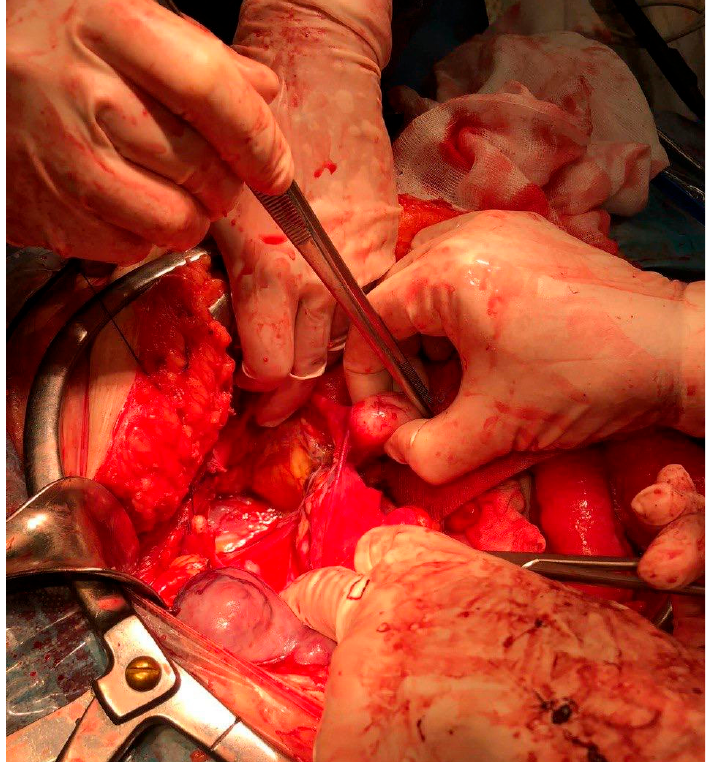
Figure 2. A picture from the operating room after removal of the largest mass. From this shot you can see the numerous rounded formations and how they relate to the other abdominal structures. It was tenaciously adherent to the prevesical peritoneum, to the small intestine, to the left colon and to the sigma. The uterus appeared irregular in shape. The adnexa were both regular in size and shape. Further nodular lesions on the abdominal and pelvic peritoneum were detected. Two omental lesions were also seen. The patient underwent a total hysterectomy, a bilateral salpingo-oophorectomy, and an omentectomy, and all the peritoneal nodules were carefully removed. The final pathology of the large abdominal– pelvic mass was positive for leiomyosarcoma of high grade, with extensive necrosis, widespread severe cytokaryological atypia, and a high mitotic index (>20/10 HPF), ki-67 = 70%. A small peritoneal lesion was a focus of endometriosis. The mass of the right pelvic peritoneum had cellulate aspects with ki-67 = 10%, and it was defined as a cellulate leiomyoma. A lesion of the posterior wall of 6 cm was a leiomyoma with bizarre nuclei.